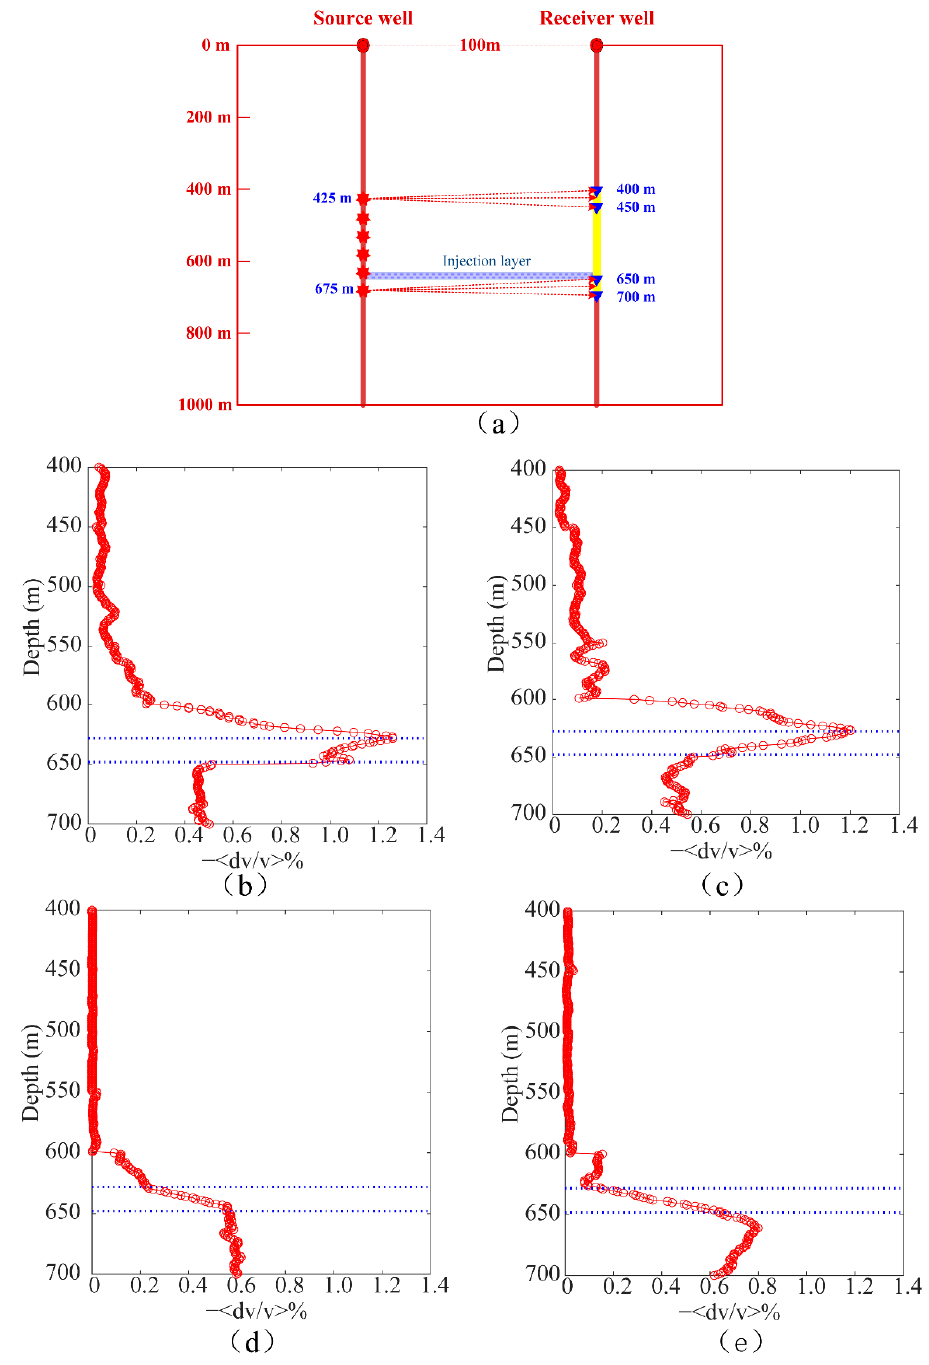
Figure 12. ( a ) The sketch shows the utilized acquisition geometry. The estimated mean velocity change versus the receiver depth from the baseline survey and the first-repeat survey using ( b ) CWI processing of the upgoing waves of the vertical component, ( c ) CWI processing of the upgoing waves of the horizontal component, ( d ) CWI processing of the downgoing waves of the vertical component, and ( e ) CWI processing of the downgoing waves of the horizontal component. Based on the above results, we found that the mean velocity changes were related to the specific subsurface structure and affects how coda waves pass through the region where velocity changes occur. The greater the wavefield that passes through the layer where the velocity change occurs, the larger the time shift will be, and thus, larger mean velocity changes